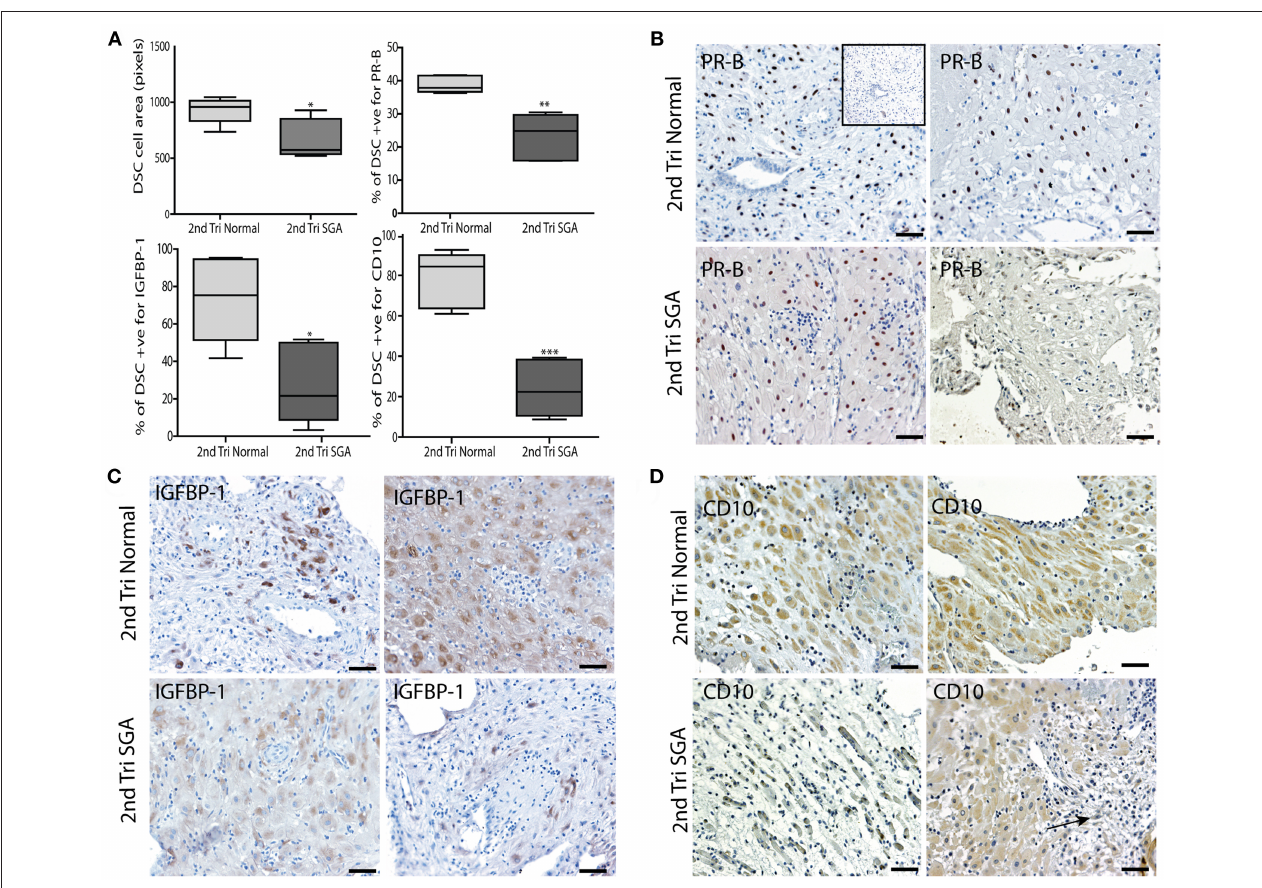
FIGURE 8 | DSC differentiation fails in the 2nd trimester high uterine artery PI SGA decidua. (A) DSC cell area was measured using the random ellipsoid measurement tool from the Olympus Cellsens software. Immunohistochemical image analysis was performed on serial decidual sections stained with antibodies against the decidual markers PR-B, IGFBP-1, and CD10. Visiopharm Newcast image analysis system and random meander sampling was used to quantify numbers of positively stained DSC in 5% of the total tissue area of each decidual section. Percentages of the total cell number were calculated and are presented as box whisker plots in (A) . Representative photographs of serial sections from 2normal 2nd trimester decidua (top panels), and 2 high uterine artery PI SGA cases (lower panels) in each case are shown stained with PR-B (B) , IGFBP-1 (C) and CD10 (D) antibodies (arrow indicates area of increased lymphatic vessel density). * p < 0.05, ** p < 0.01, *** p < 0.0001, n = 6 in each group. Inset shows no staining with the Rabbit IgG negative control. Scale bar = 50 µ M, 100x